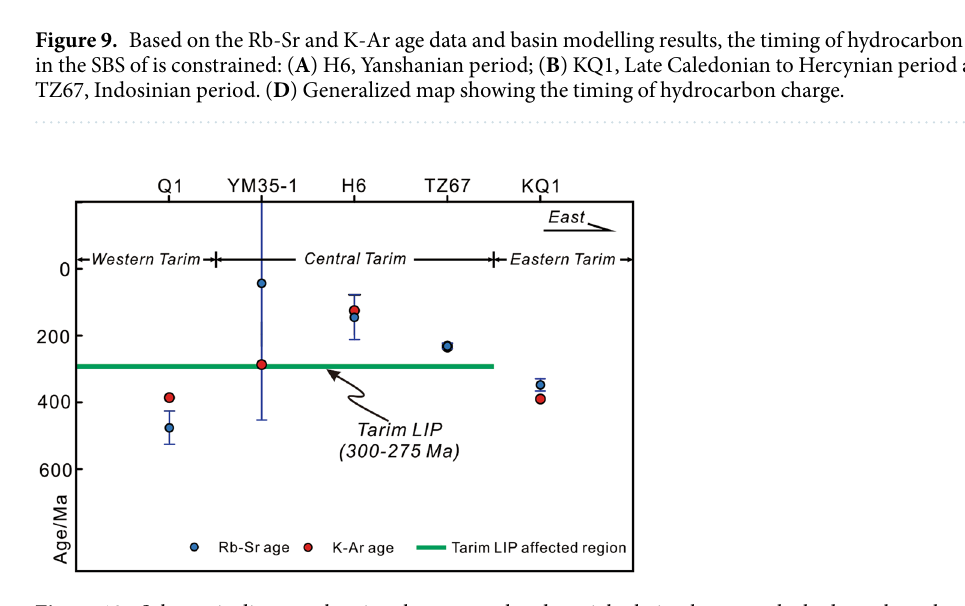
Figure 10. Schematic diagram showing the temporal and spatial relation between the hydrocarbon charge and early Permian Tarim LIP in the Tarim